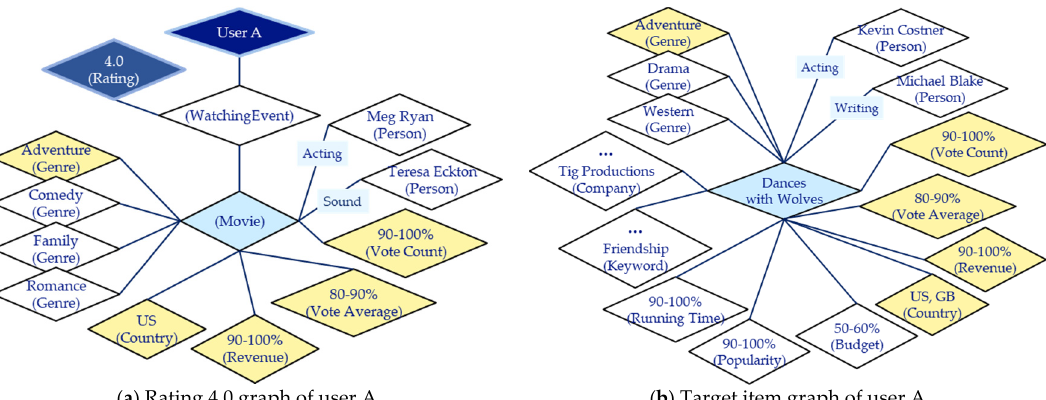
Figure 17. User rating ontology schema (movie domain).